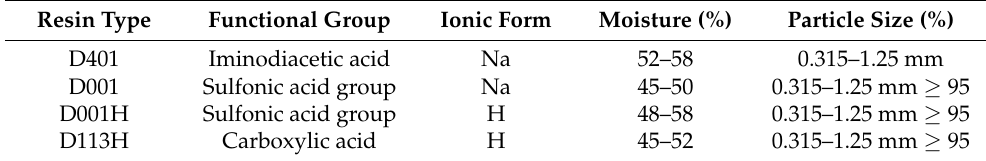
Table 1. Characteristics of